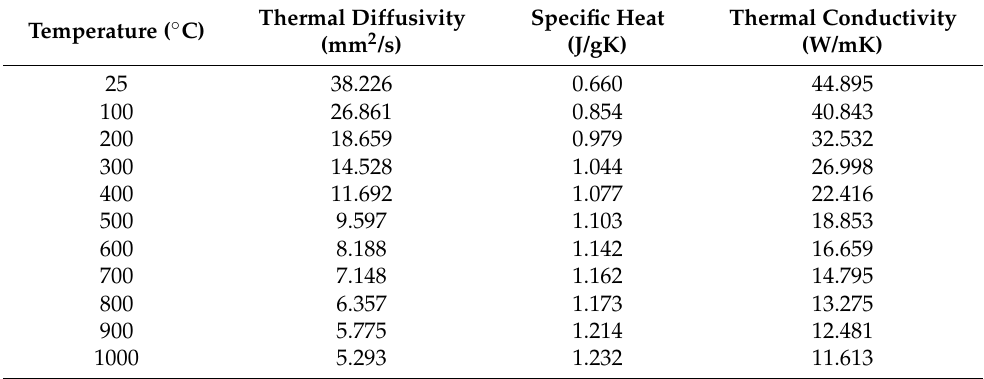
Table 7. Thermophysical properties of the aged samples obtained from slabs 9 and 11. Average values of the two